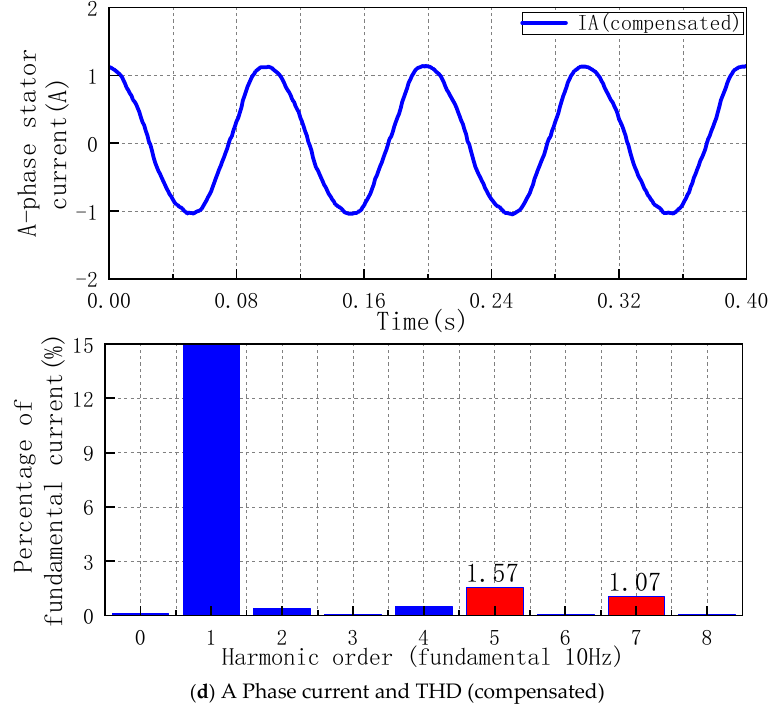
Figure 14. Experiment data for 200 rpm condition.